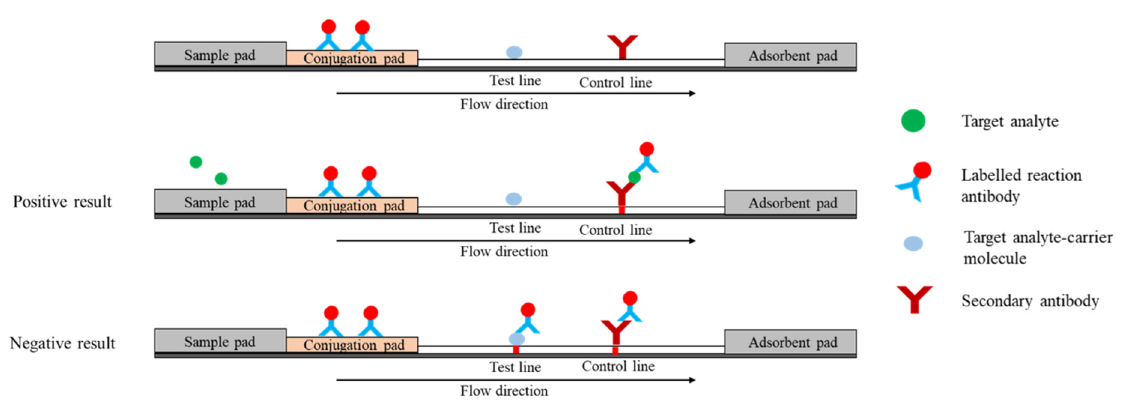
Figure 4. Schematic diagram shows competitive format (second